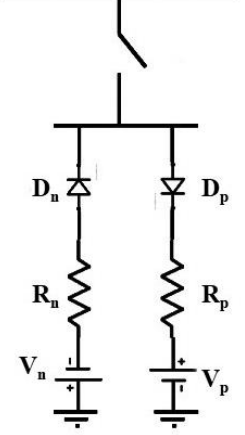
Figure 1. Representation of Simplified HIF Model.